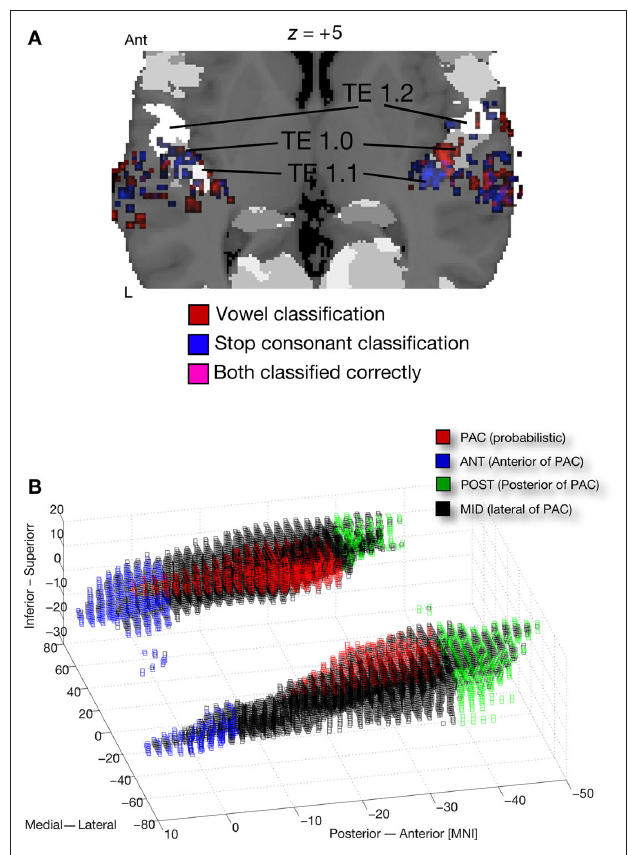
FIguRe A3 | (A) Overlay of classification results on Probability map of primary auditory cortex, using the labels of Morosan et al., 2001 (TE 1.2–TE 1.0). Notably, TE 1.2 appears relatively spared by voxels that allow significant across-subjects classification of vowel or consonant category. (B) Illustration of regions of interest used. A simple selection procedure was done, such as that voxels that fell within the probabilistic bounds of primary auditory cortex were defined following Rademacher et al., 2001 (lPAC, rPAC); voxels anterior to that (lANT, rANT) and posterior to that (lPOST, rPOST) were used to define regions, as well as voxels that were within the posterior–anterior bounds of PAC but more lateral (lMID,